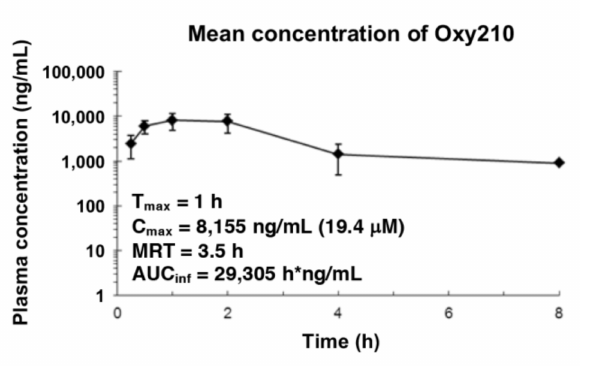
Figure 4. Pharmacokinetics of Oxy210 in mice. A single dose of Oxy210 at 200 mg/kg, formulated in 3% DMSO + 7% Ethanol + 5% PEG400 + 85% corn oil, was administered to balb/c mice by oral gavage. Plasma samples were taken at 0.25, 0.5, 1, 2, 4, and 8 h, followed by LC/MS analysis of the plasma to quantify Oxy210